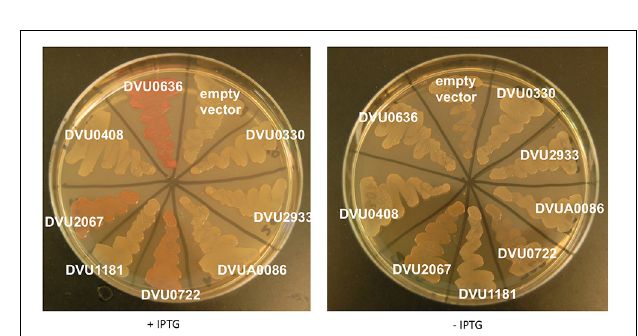
FIGURE 7 | E. coli Congo Red binding assay. E. coli BL21 strains expressing full length proteins with C-terminal V5 and His tags were plated on LB-Carb plates with CR (5 μ g/ml), with and without IPTG. Plates were incubated at room temperature and imaged after 4 days of growth. slight orange tinge was visible in the absence of IPTG as